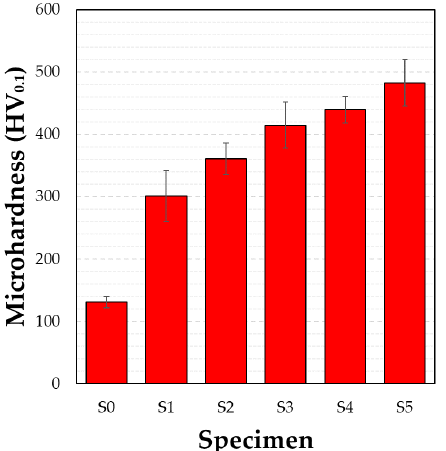
Figure 12. The average micro-hardness values of the bare and Zr-coated Al6061 alloys surface.